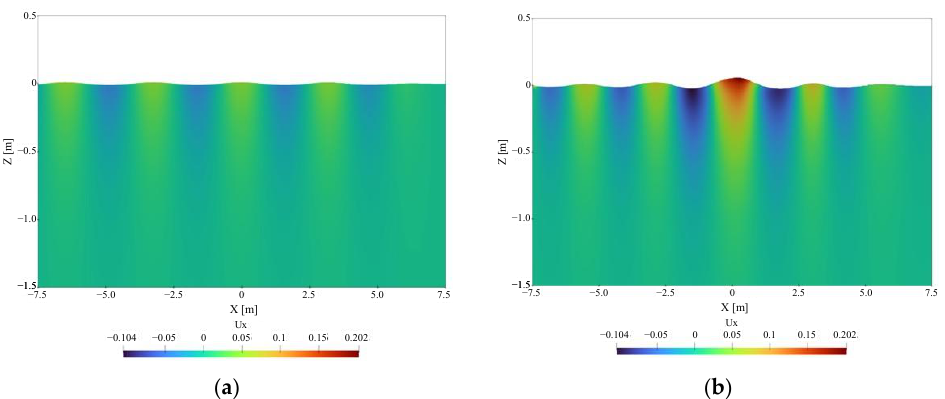
Figure 15. X-velocity contours of water phase at y = 0 plane: ( a ) regular wave; ( b ) rogue wave.